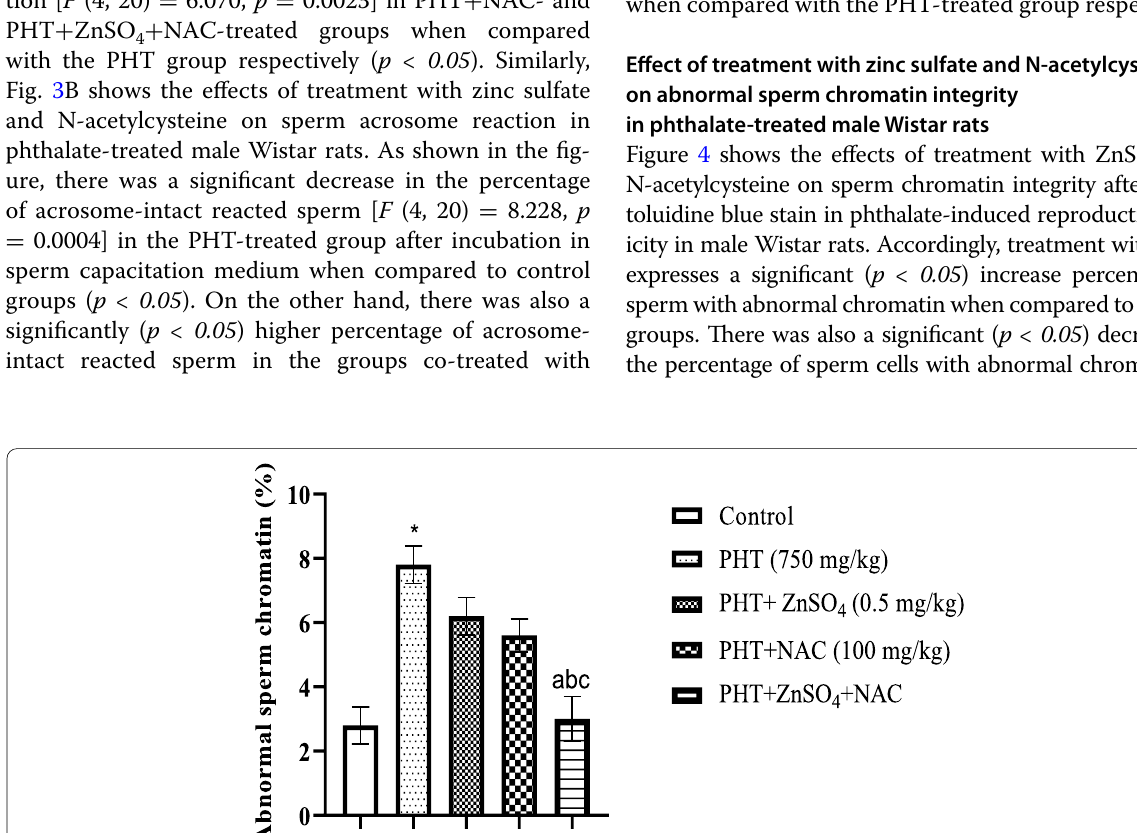
5, PHT phthalate, ZnSO 4 zinc = ZnSO 4 ‑, and +